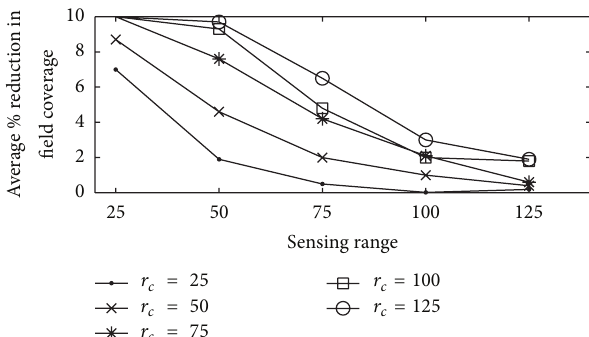
Figure 9: Reduction in field coverage for proposed technique versus sensing range (m) for different communication range